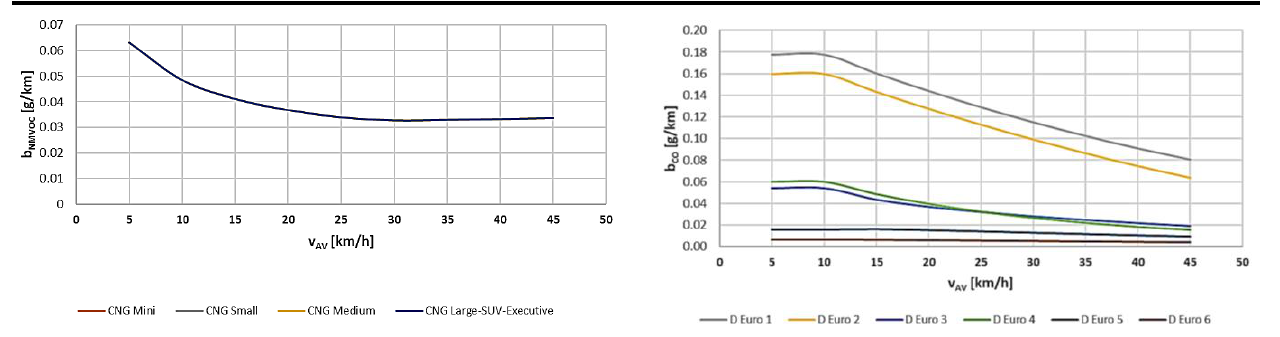
Fig. 30. CO emission from diesel oil PCs for Euro standards depending on average speed